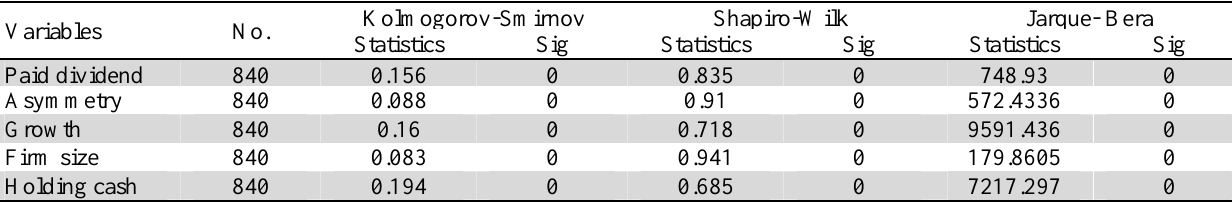
The summary of testing normality Variables